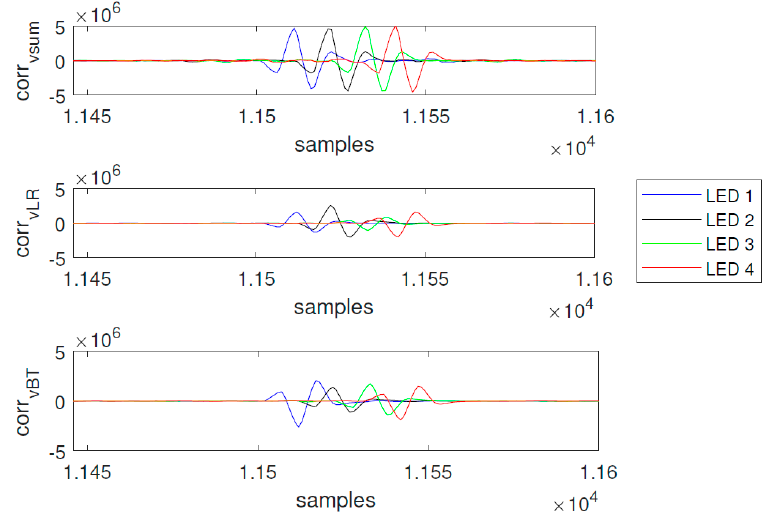
Figure 10. Zoom around the central peaks of the correlations presented in Figure 9.